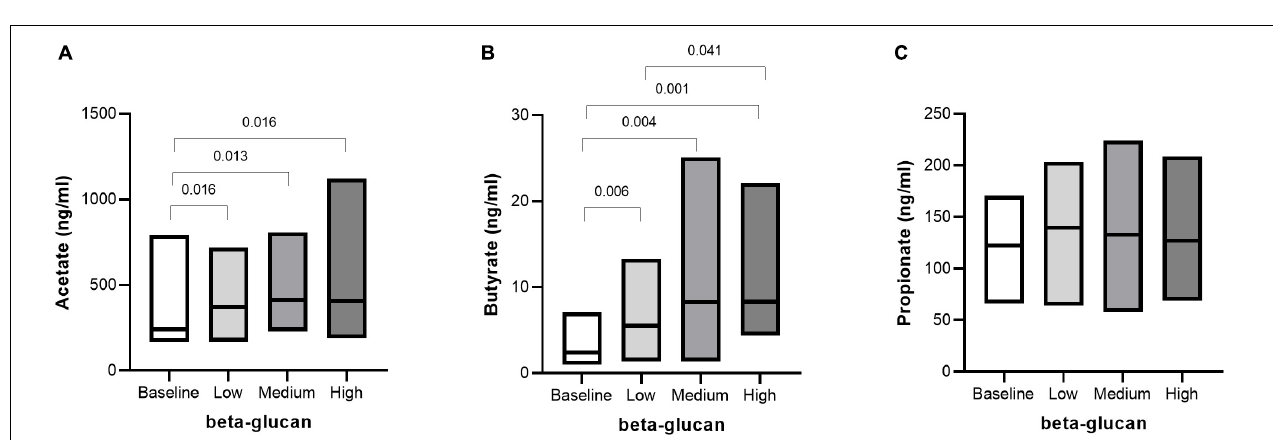
FIGURE 6 | Fasting and postprandial response of H2 breath after intake of granola with cereal beta-glucan. The postprandial response from 0 to 180 min (A) and the incremental area under the curve (B) after an OGTT at baseline and after consuming low, medium and high amount of beta-glucan for three days. Data is given as median (25 th –75 th ). Significant differences are calculated with Friedman’s Anova followed by Wilcoxon signed rank test. *H 2 response (0–180 min) after low, medium, and high beta-glucan significant different from baseline. #H 2 response (0–180 min) after high beta-glucan significant different from low and medium beta-glucan.